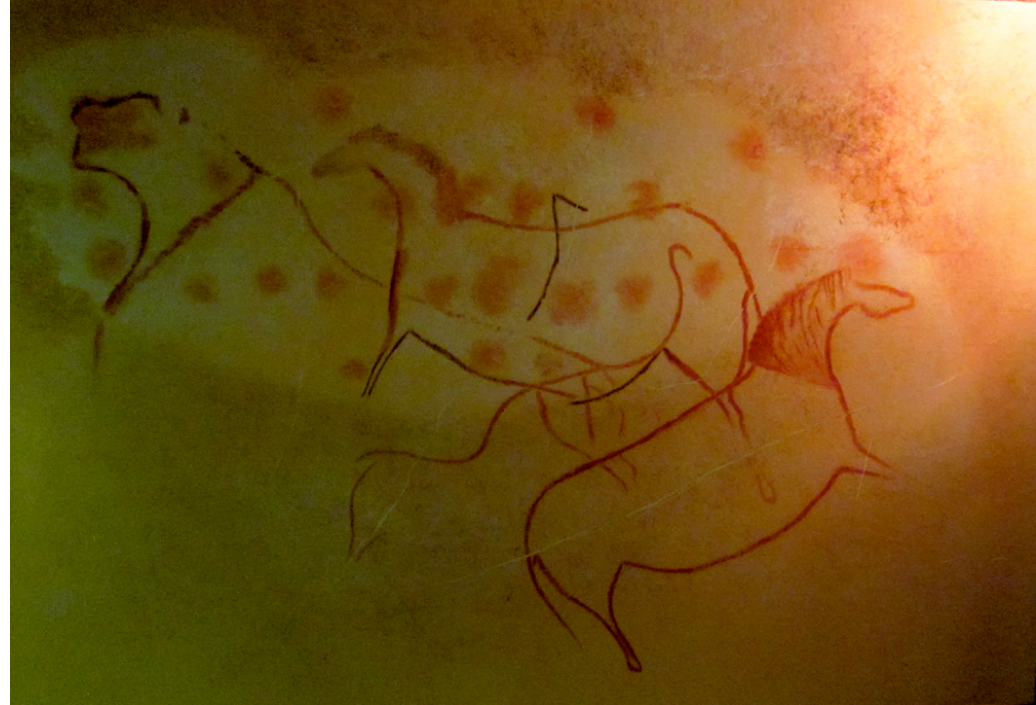
Figure 3. Spotted horses from Lion’s Den , le Combel Cave. Photograph by B.